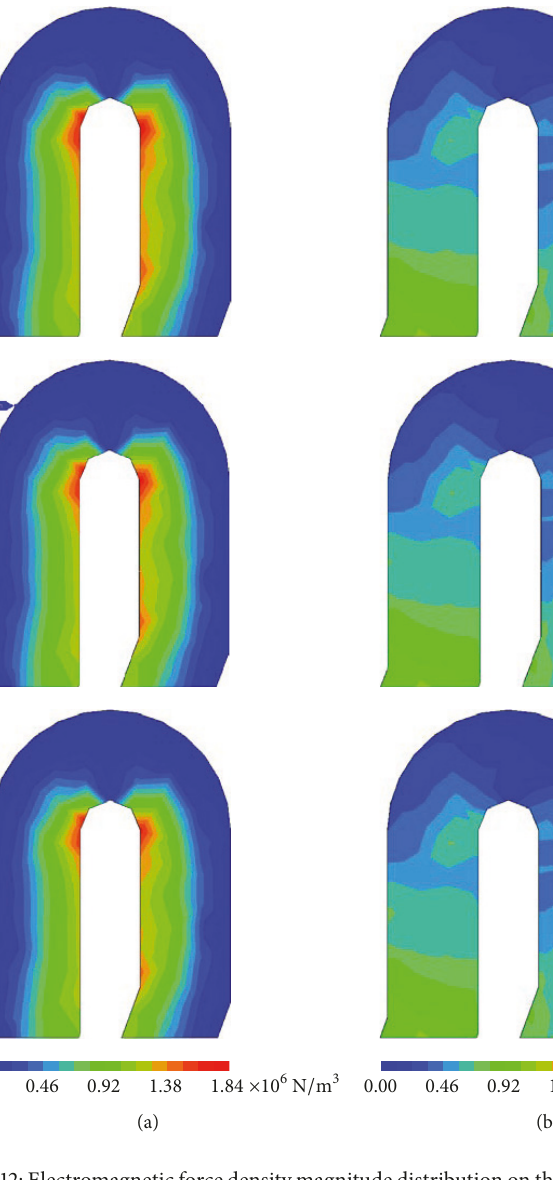
forces. When 𝑙 𝑟 increases from − 75 mm to +75 mm, the radial force increases by 13% while the tangential and axial forces decrease by 9% and 12%,